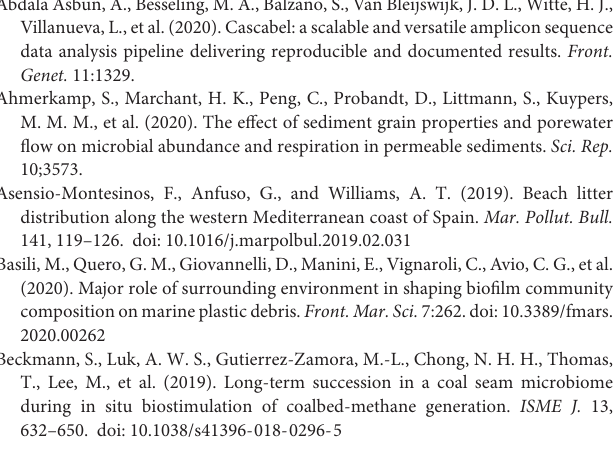
Supplementary Table 1 | Statistical analysis. Supplementary Table 2 | FISH probes used in this